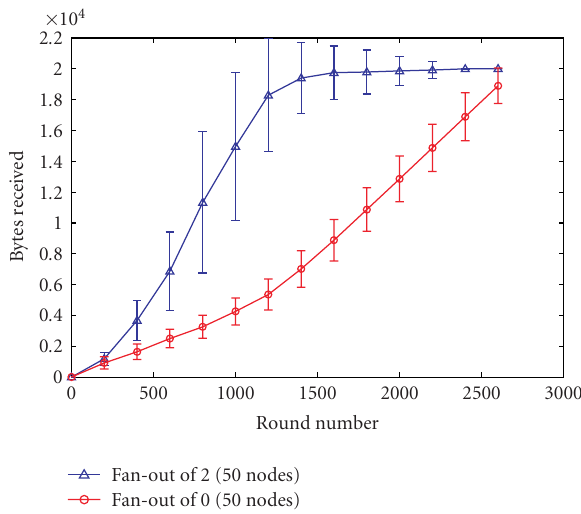
Figure 15: Simulation when stream block sizes are varied according to the incentive mechanism of